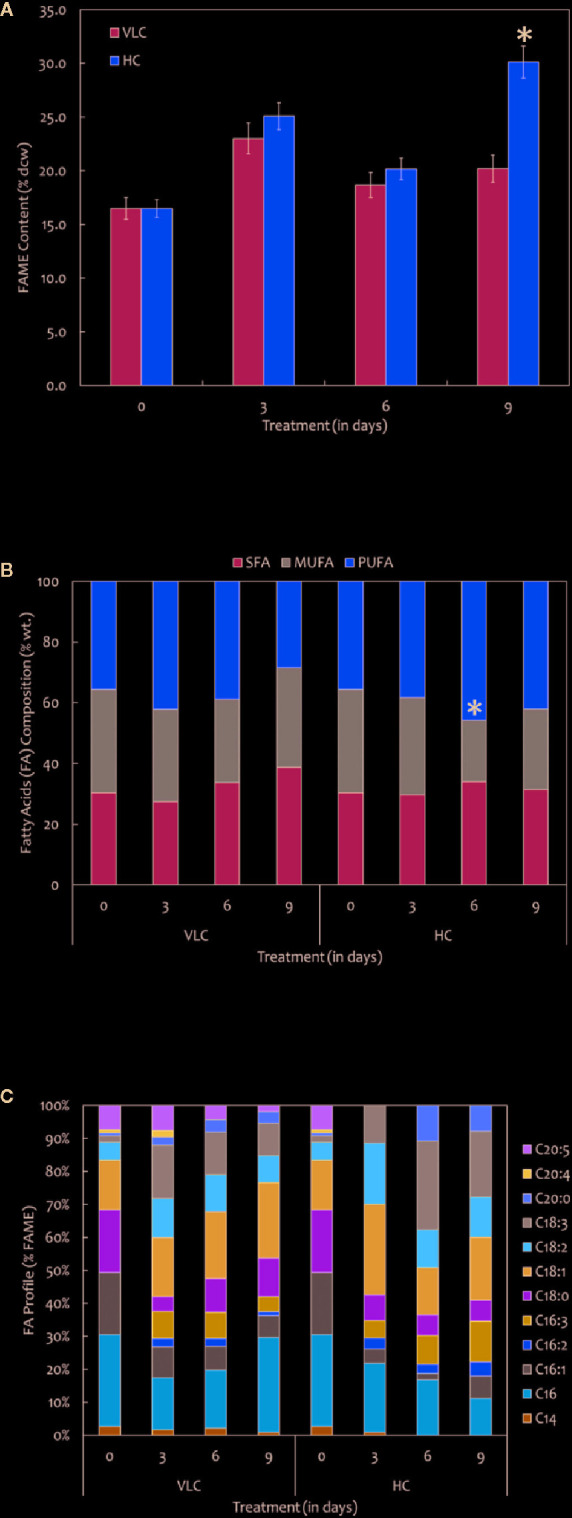

(A) Quantitative analysis of total fatty acid methyl esters (FAMEs) in M. gaditana (in % dcw) supplemented with VLC and HC. (B) Bar diagram representing the saturation and unsaturation ratio of fatty acids (% of FAME) in M. gaditana (SFA, saturated fatty acids; MUFA, mono-unsaturated fatty acids; PUFA, poly-unsaturated fatty acids). (C) FAME profile depicting the distribution of individual fatty acids in M. gaditana subjected to VLC and HC. * indicate statistical significance by one-way ANOVA, p-value < 0.05.